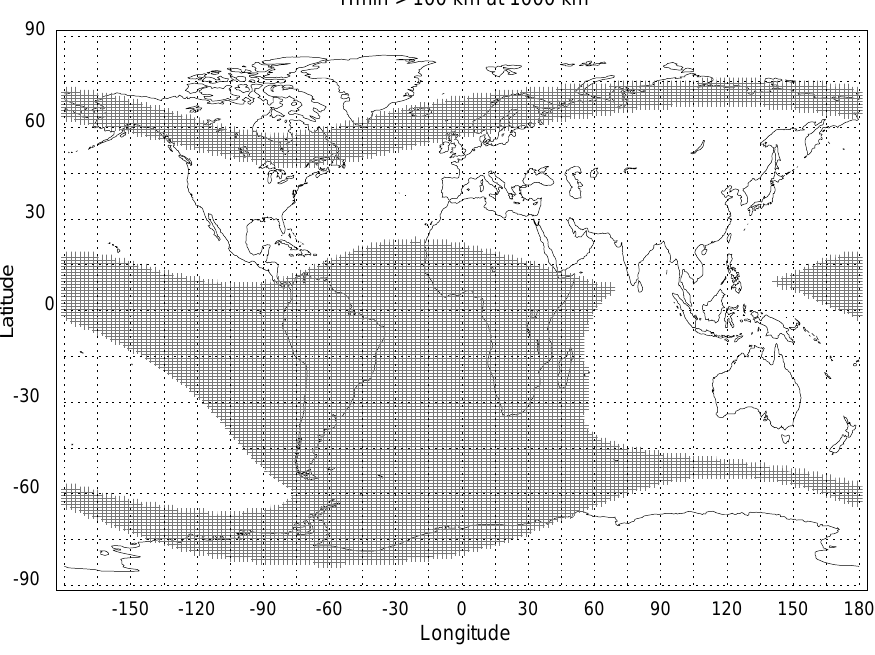
Fig. A2 Same as Fig. A1 for altitude of